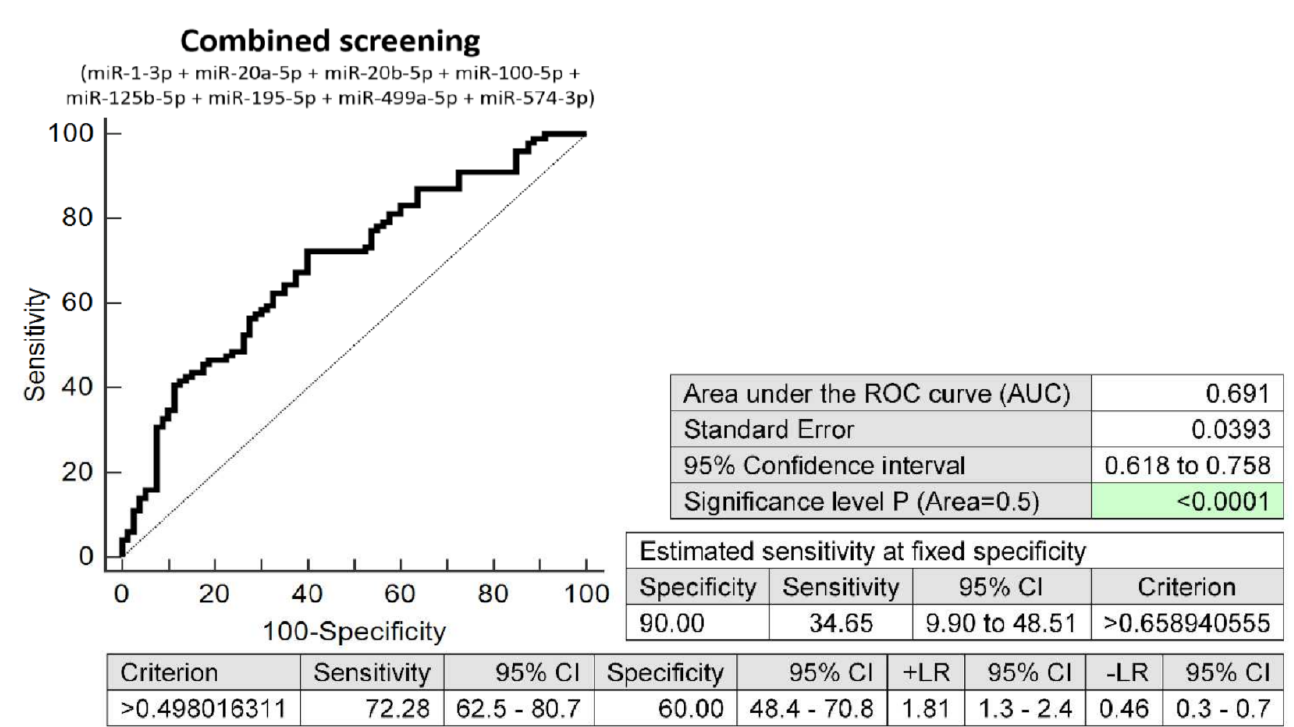
Figure 8. ROC analysis—the combination of microRNA biomarkers (miR-1-3p, miR-20a-5p, miR- 20b-5p, miR-100-5p, miR-125b-5p, miR-195-5p, miR-499a-5p, and miR-574-3p). A total of 34.65% pregnancies destinated to develop GDM on diet only had an aberrant microRNA expression profile in the whole peripheral venous blood during the first trimester of gestation at a 10.0% FPR. This represents 35 out of 101 pregnancies correctly predicted to develop GDM and 8 out of 80 normal pregnancies predicted false positively to develop